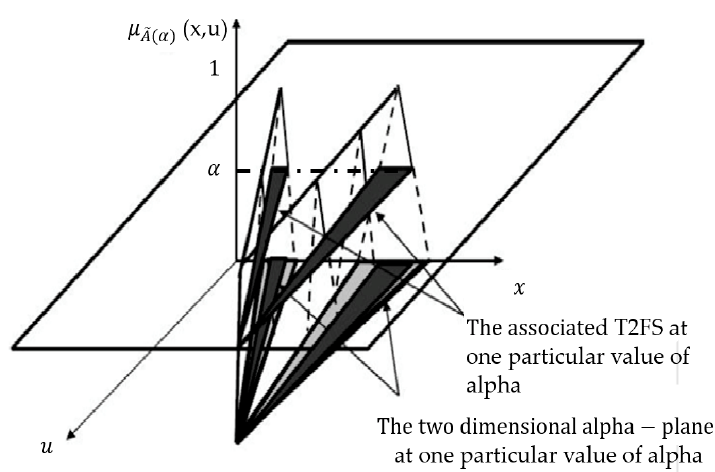
Figure 6. An example of the associated type-2 fuzzy set for the alpha-plane.